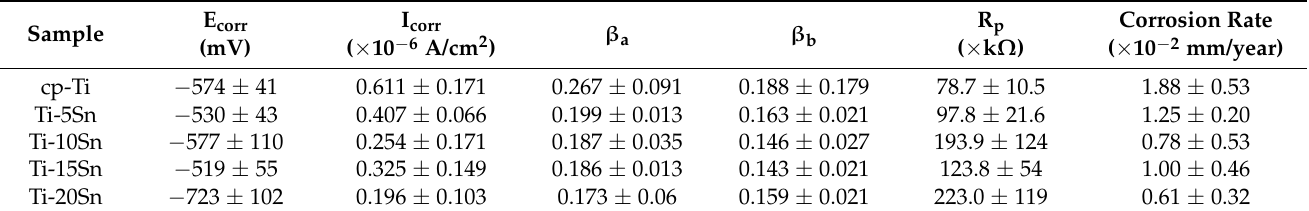
Table 3. Potentiodynamic polarization curve analysis results using the Tafel extrapolation method ( n =